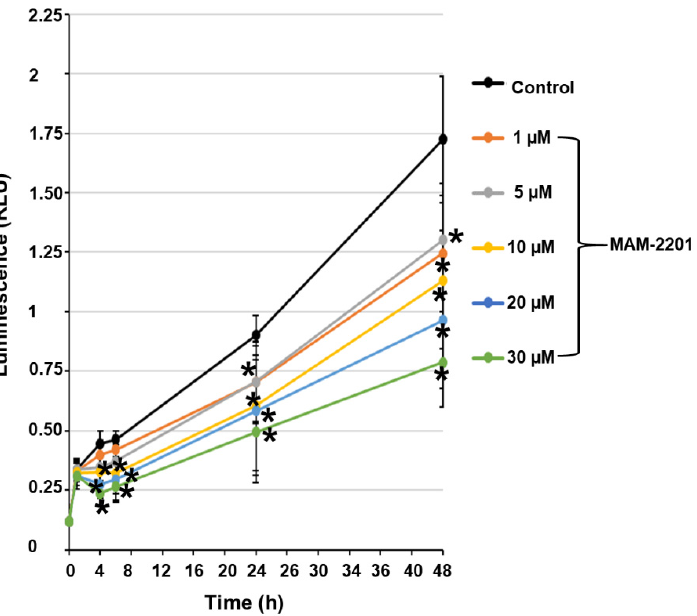
Figure 6. Cell viability over time. Time- and concentration-dependent MAM-2201 effects: the effect started at ≥ 10 µM of MAM-2201 after 4 h and at ≥ 5 µM after 24 h of exposure. Results are provided as means ± S.E. of two independent experiments performed in eight replicates. * p < 0.05, statistical analysis by one-way ANOVA followed by Tukey’s multiple comparisons test.